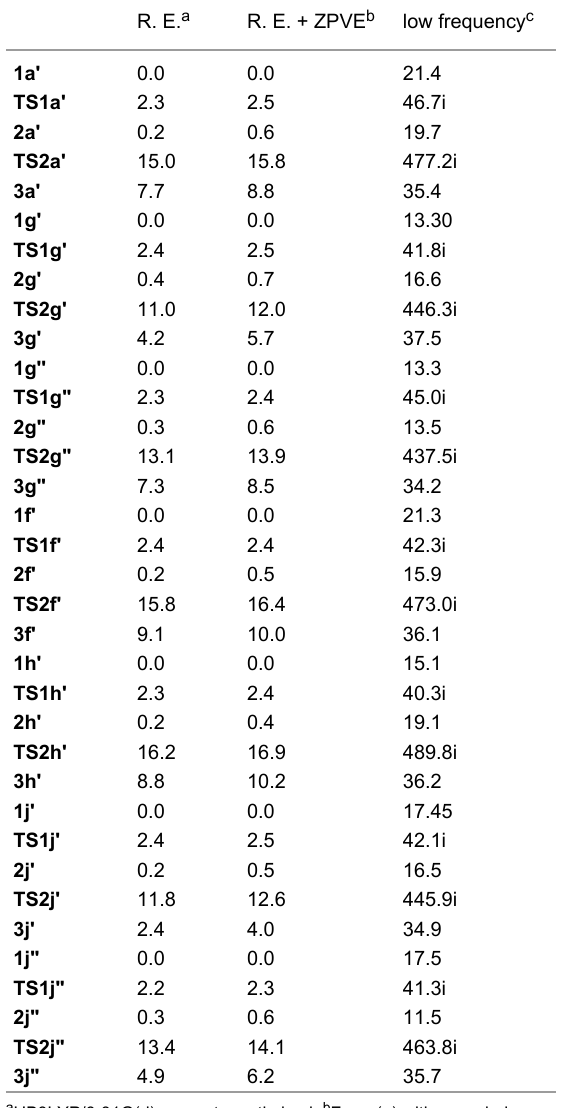
Table 3: Energies (R. E. kcal/mol) of calculated structures. Energies are relative to the open form of the